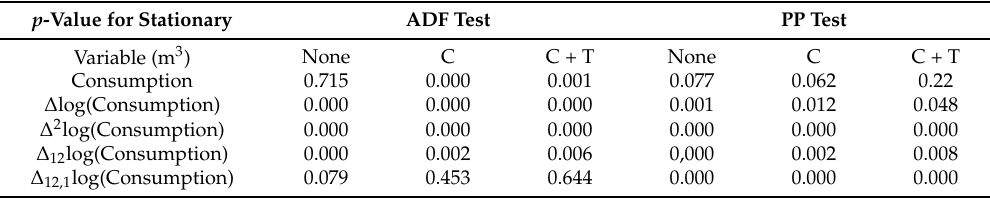
Table 4. Stationary test for consumption